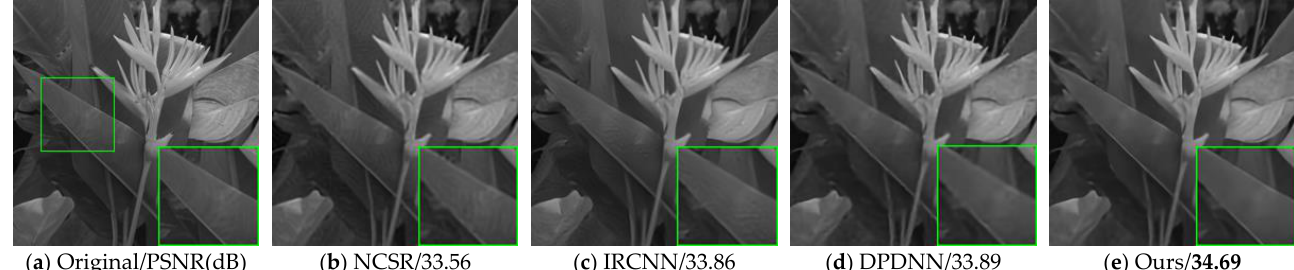
Figure 8. Image deblurring results on Plant in Figure 3 with 25 × 25 Gaussian kernel and σ n = 2. ( a ) The original image. ( b )